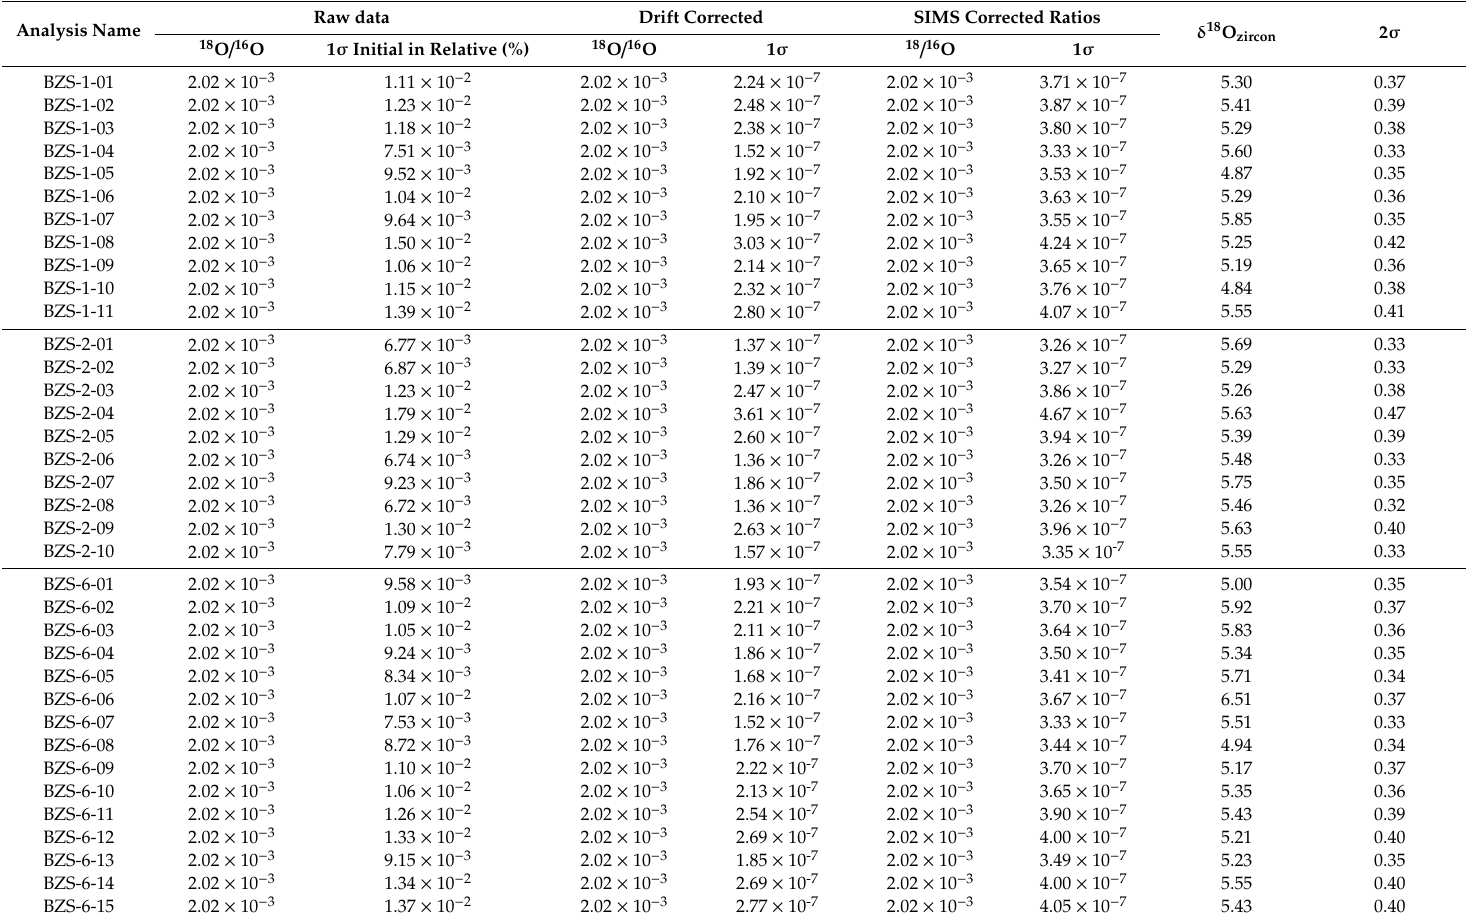
Table 4. In situ secondary ion mass spectrometry (SIMS) zircon oxygen isotope compositions for the Banzhusi granite